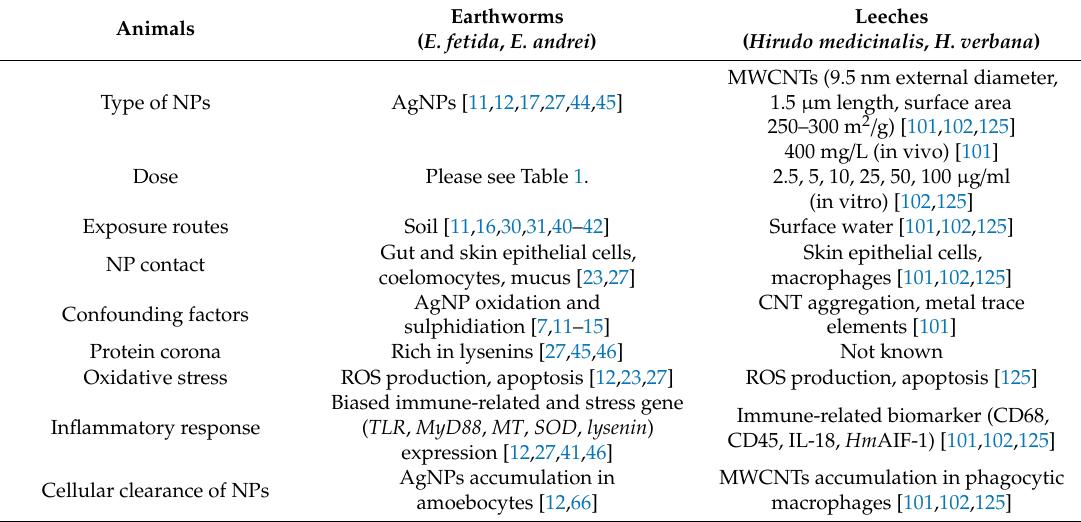
Table 2. Summary of the NP-related factors and e ff ects on annelid